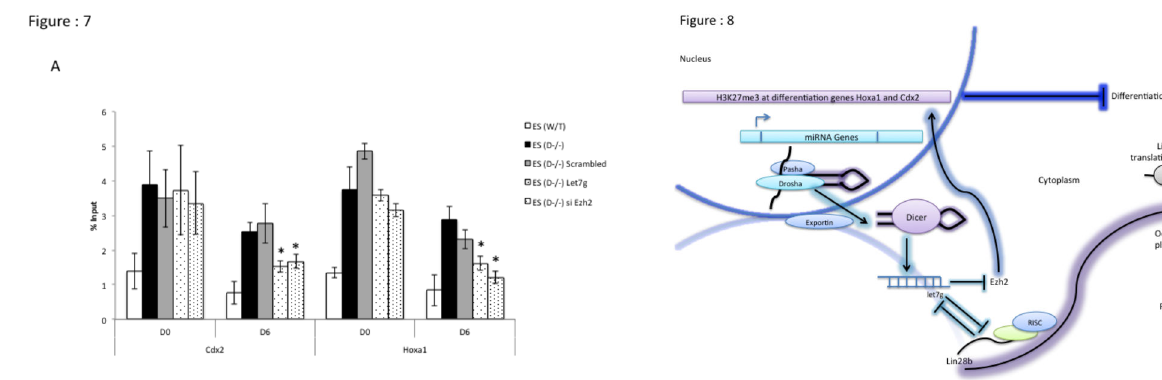
and Dicer -/- ES cells treated with si Ezh2, or let-7g mimic were significant at 0.05 confidence levels when a students t-test was